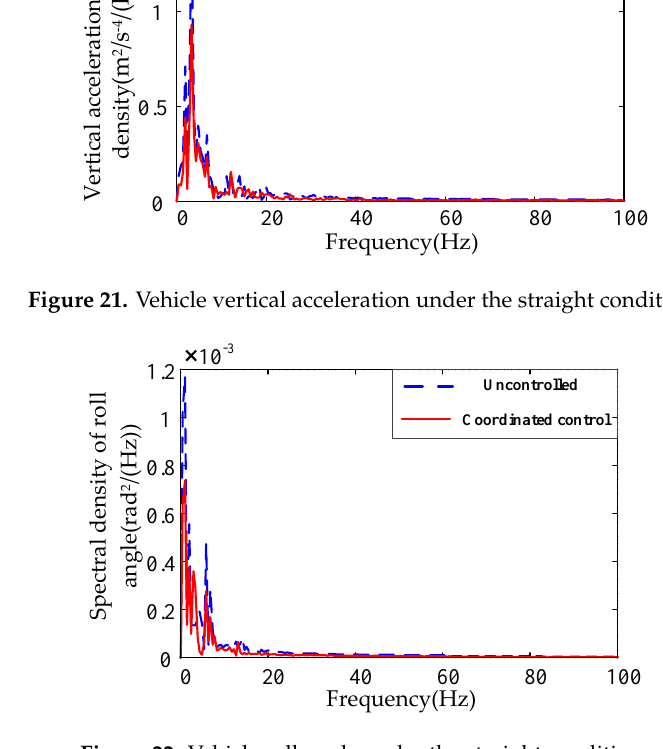
Energies 2019 , 12 , x FOR PEER REVIEW Figure 22. Vehicle roll angle under the straight condition. Figure 22. Vehicle roll angle under the straight condition. Figure 22. Vehicle roll angle under the straight condition.